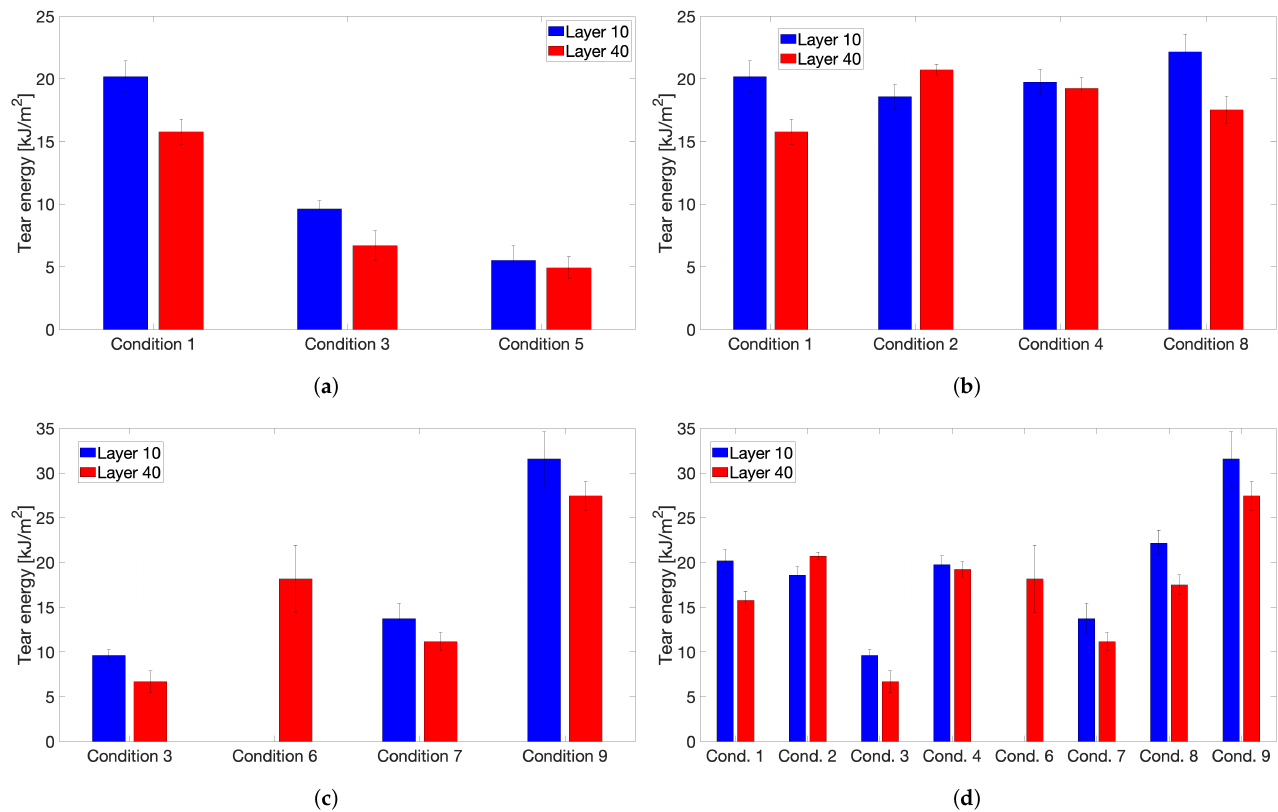
Figure 10. An overview of the calculated tear energies G III and thus the extent of interlayer bond strength for all printing conditions. ( a ) Effect of T liquefier = 260, 240 and 220 °C for conditions 1, 3 and 5, respectively. ( b ) Effect of v print = 11 mm/s for conditions 1 and 2, and 5.5 mm/s for conditions 4 and 8. ( c ) Effect of M w . HMWPA for conditions 3 and 7 and LMWPA for conditions 6 and 9. ( d ) Effect of T build plate = 110 °C for conditions 1, 3, 4 and 6, and 40 °C for conditions 2, 7, 8 and